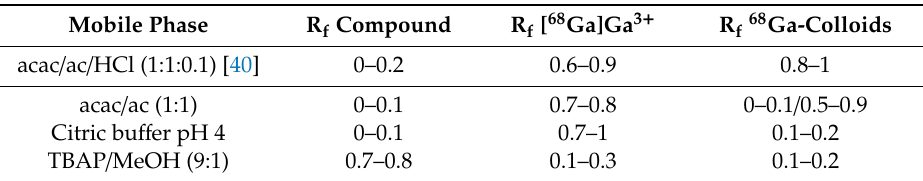
Table 1. List of the published (first row) and the finally used radio thin-layer chromatography (TLC)